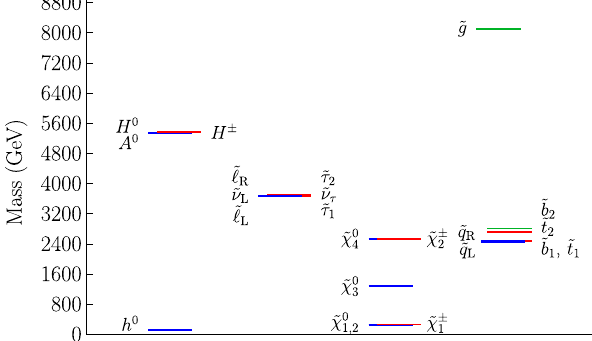
Fig. 1 Sparticle mass spectrum of the best-fit